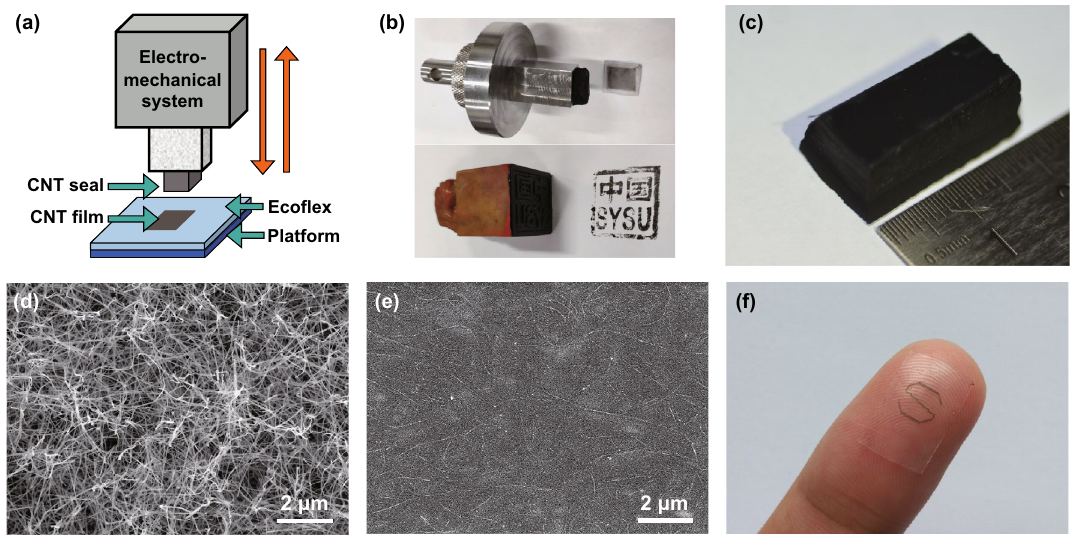
Fig. 1 Schematic of the fabricating process and as-prepared samples of CNT films by stamp method. a Schematic illustration of the fabricating process. b Photograph of the CNT seal and stone seal. c Photograph of the CNT block. d SEM image of CNT block. e SEM image of the CNT film on Ecoflex substrate. f Transferred CNT film with an “S”